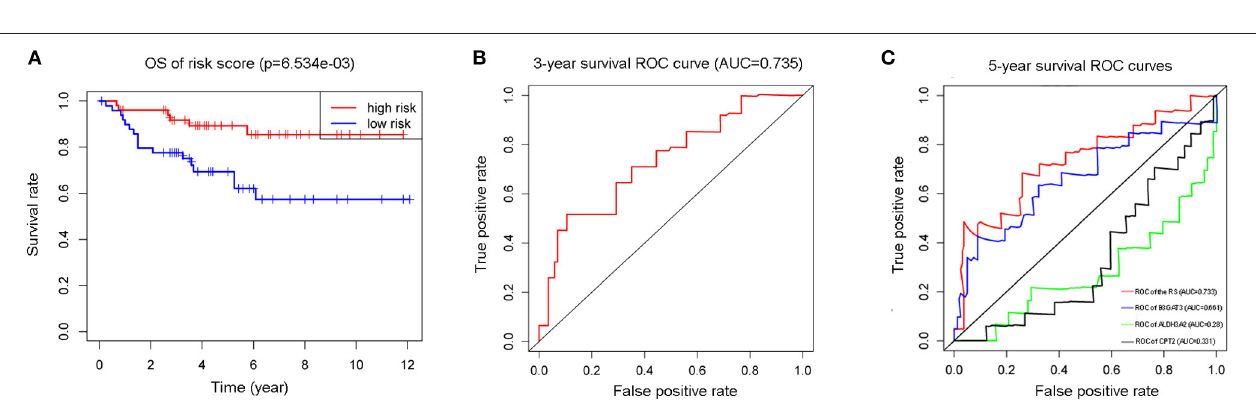
FIGURE 6 | The K-M plot (A) and 3-year survival ROC curve (B) of the RS model, and the 5-year survival ROC curves of the RS model with its component genes: ALDH3A2, B3GAT3, and CPT2 (C) in validation cohort E-MTAB-1980.